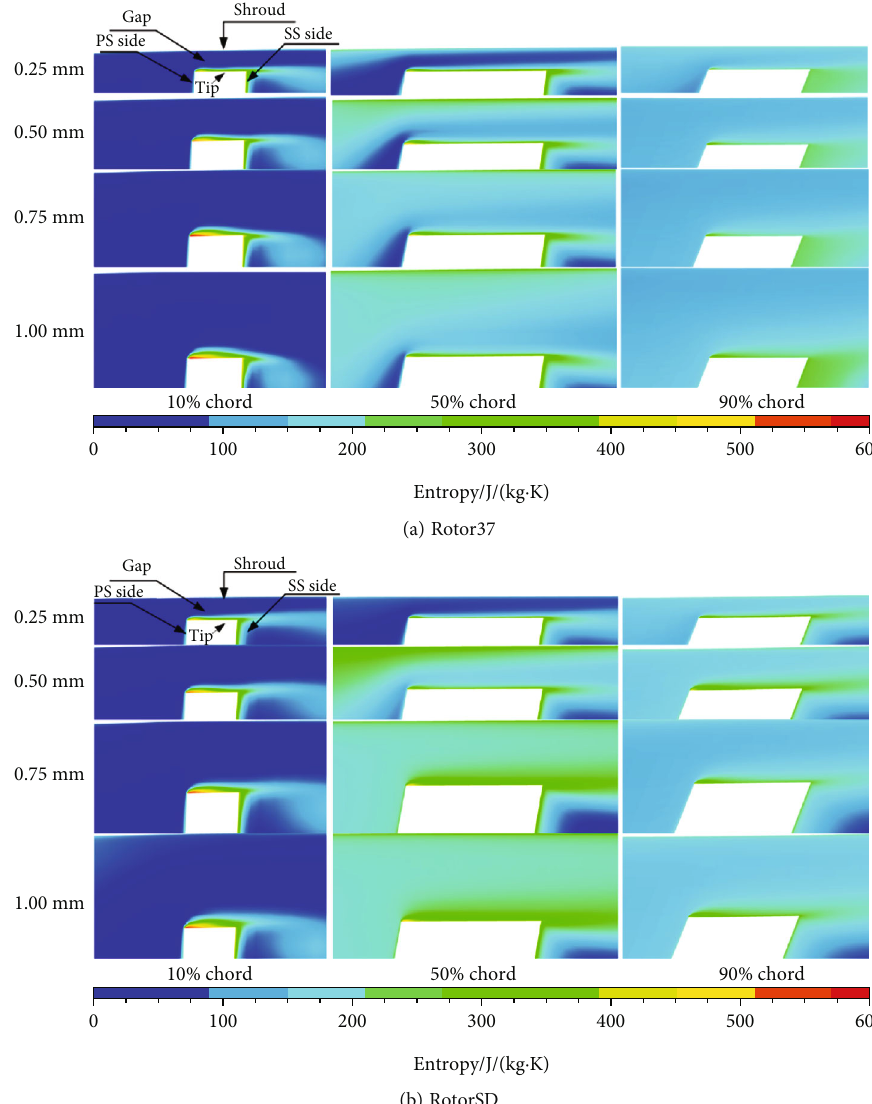
Figure 29: Contour of entropy at the tip clearances at 10%, 50%, and 90% chords.